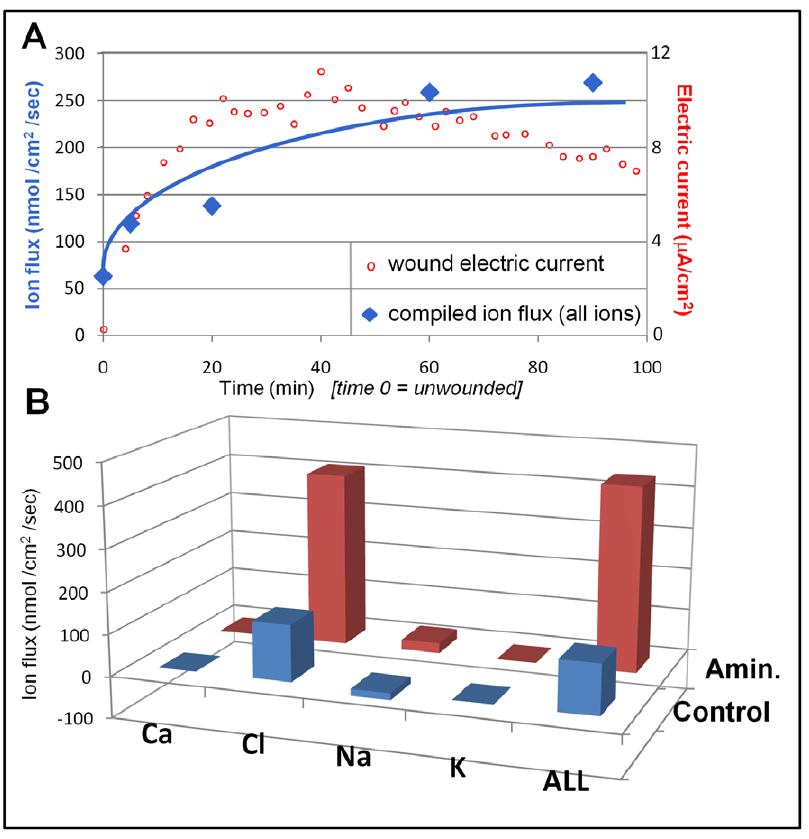
Figure 7. Relative contributions of ions to wound current. A. Timelapse. Overlaying wound electric current data (red) with compiled ion flux data (flux of all ions combined; blue) shows that electric current increase after wounding is due to an increasing ion flux (mainly chloride). Wound electric current data from Reid et al. [6]. B. Combined ion flux. We compiled ion flux data at 5 min after wounding. Chloride is the major ion contributing to the normal (‘Control’; blue) wound current. Enhancement of wound current by aminophylline (‘Amin.’; red) is mostly due to stimulation of chloride flux, but also partly by reversal of sodium flux (inward to outward).